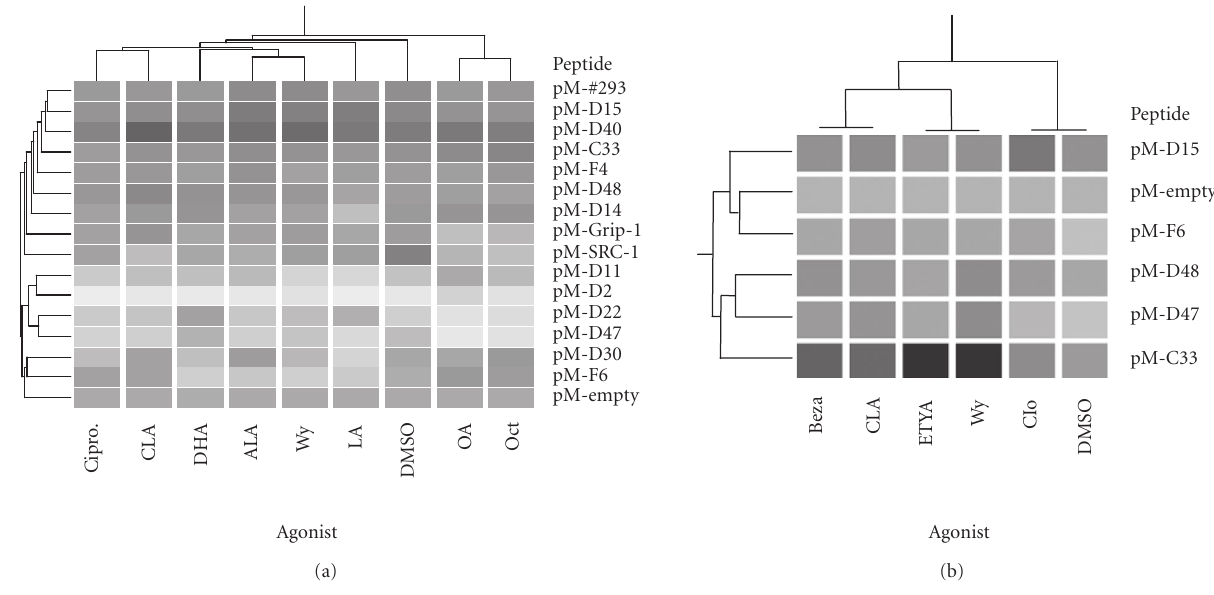
Figure 4: Interaction between LXXLL peptides and PPAR α in mammalian two-hybrid assay. COS-1 cells were grown in serum-free media for 12 hours before transfection with GAL4DBD(pM)/peptide fusions, VP16/PPAR α , pFR-luciferase, and pRL-TK. Panel (a): cells were treated with 100 μ M α -linolenic acid (ALA), linoleic acid (LA), docosahexaenoic acid (DHA), conjugated linoleic acid (CLA), octanoic acid (OCT), oleic acid (OA), 25 μ M Wy-14,643 (Wy), 25 μ M ciprofibrate (Cipro), or DMSO (0 . 1%v/v) for 6 hours. Panel (b): cells were transfected and treated as described above with DMSO, CLA, Wy, and also with 100 μ M eicosatetraynoic acid (ETYA), bezafibrate (Beza), or clofibrate (Clo). Luciferase activity was measured and corrected for extraction yield and transfection e ffi ciency ( n = 3). Data was expressed relative to that of the pM-empty construct and the presented heat map was generated in GeneSpring (Agilent, Palo Alto, CA). Darker shading represents higher luciferase